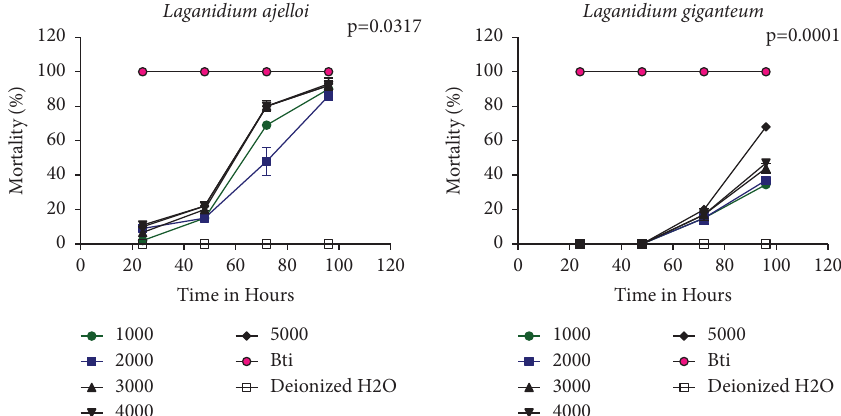
Figure 5: Percent mortality of Lagenidium giganteum and L. ajelloi zoospores against A. gambiae larvae at diferent time intervals. Te positive control ( Bti ) caused larval mortalities signifcantly faster than all the test zoospore concentrations, but there were no signifcant diferences in killing time between the various zoospore concentrations for both